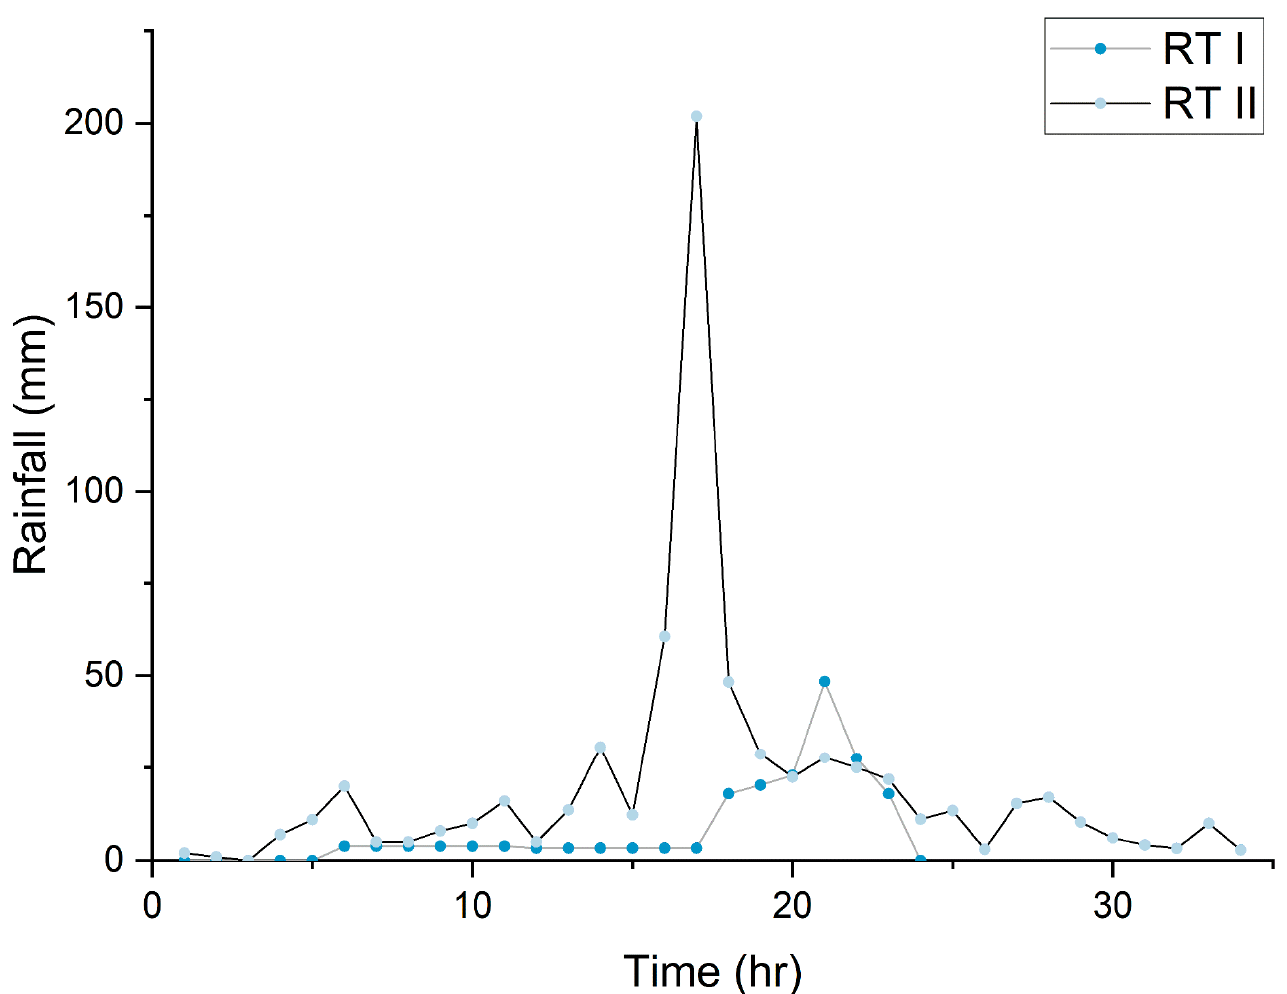
Figure 8. The hyetographs of rainfall type I (RT I) and rainfall type II (RT II), with a time interval of 1 h.